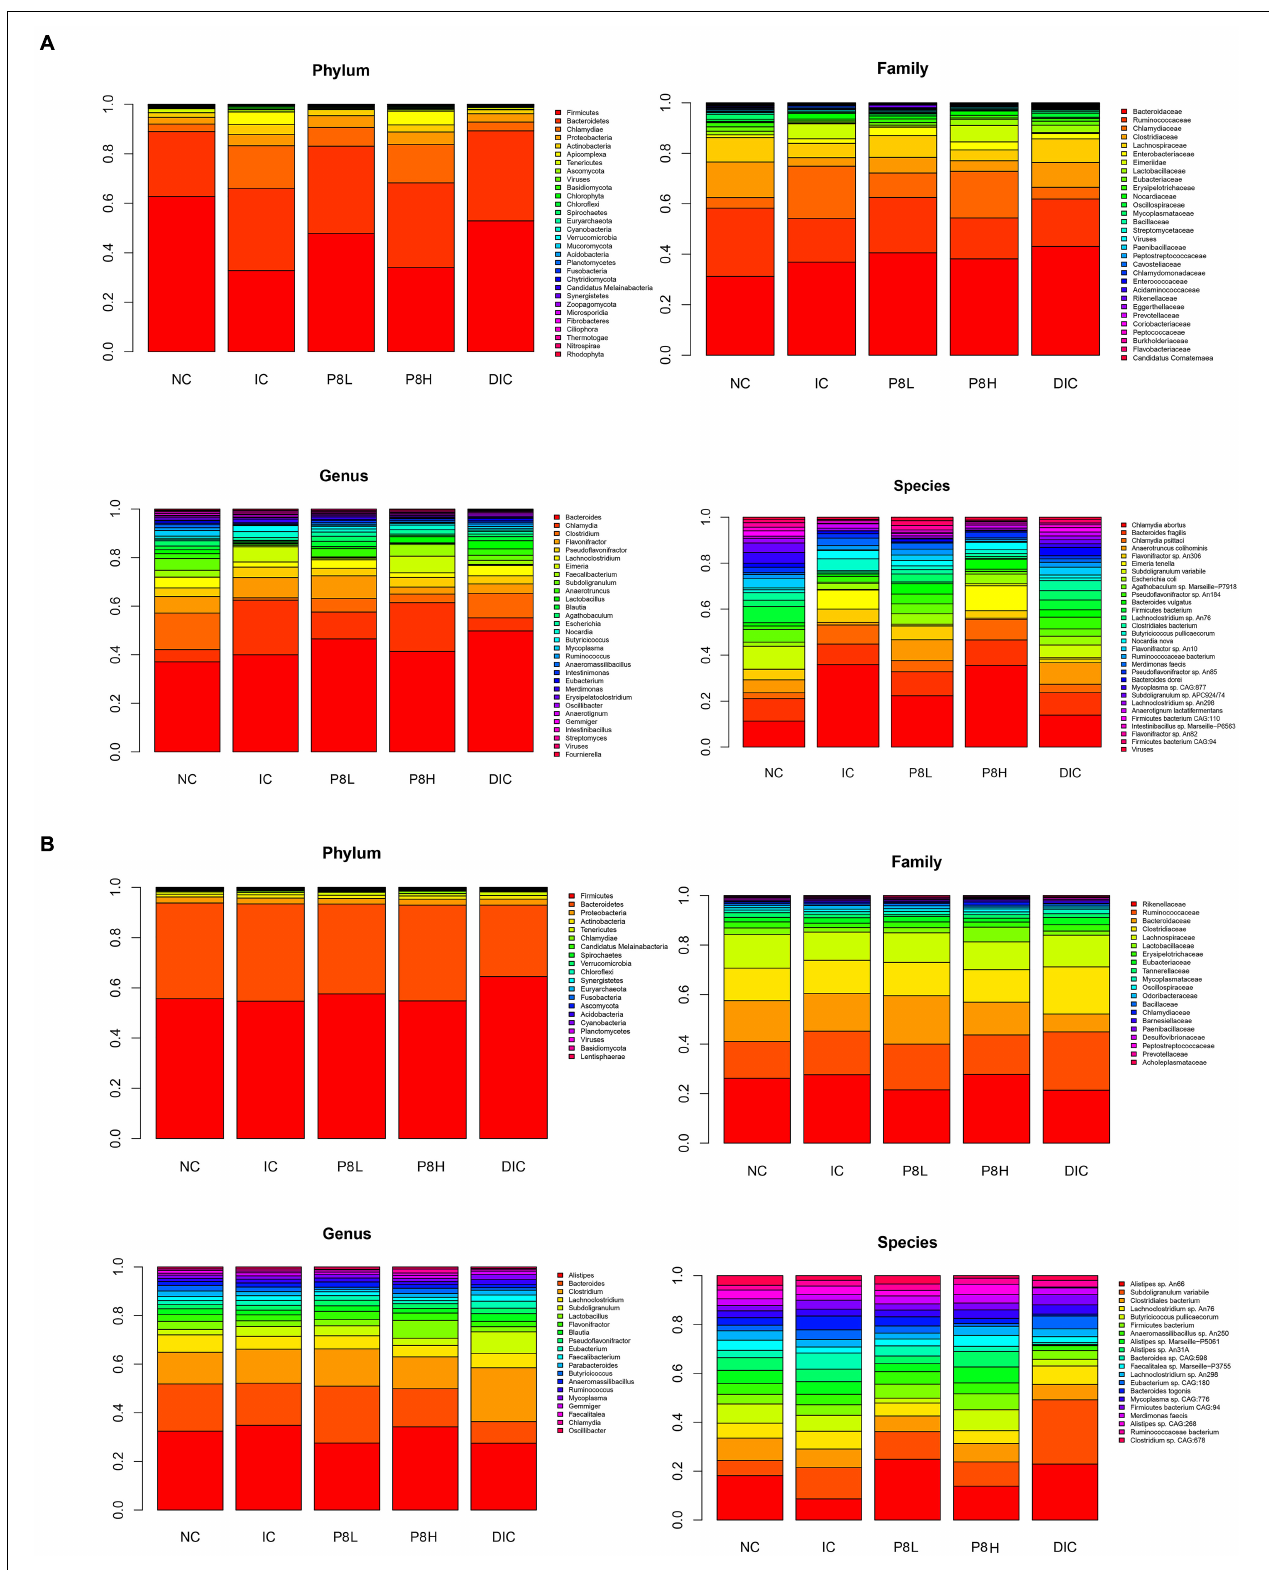
FIGURE 4 | Effects of P8 on the abundance of gut microbiota and coccidia in broilers of Eimeria -infected broilers. (A) Day 21, (B) day 42.